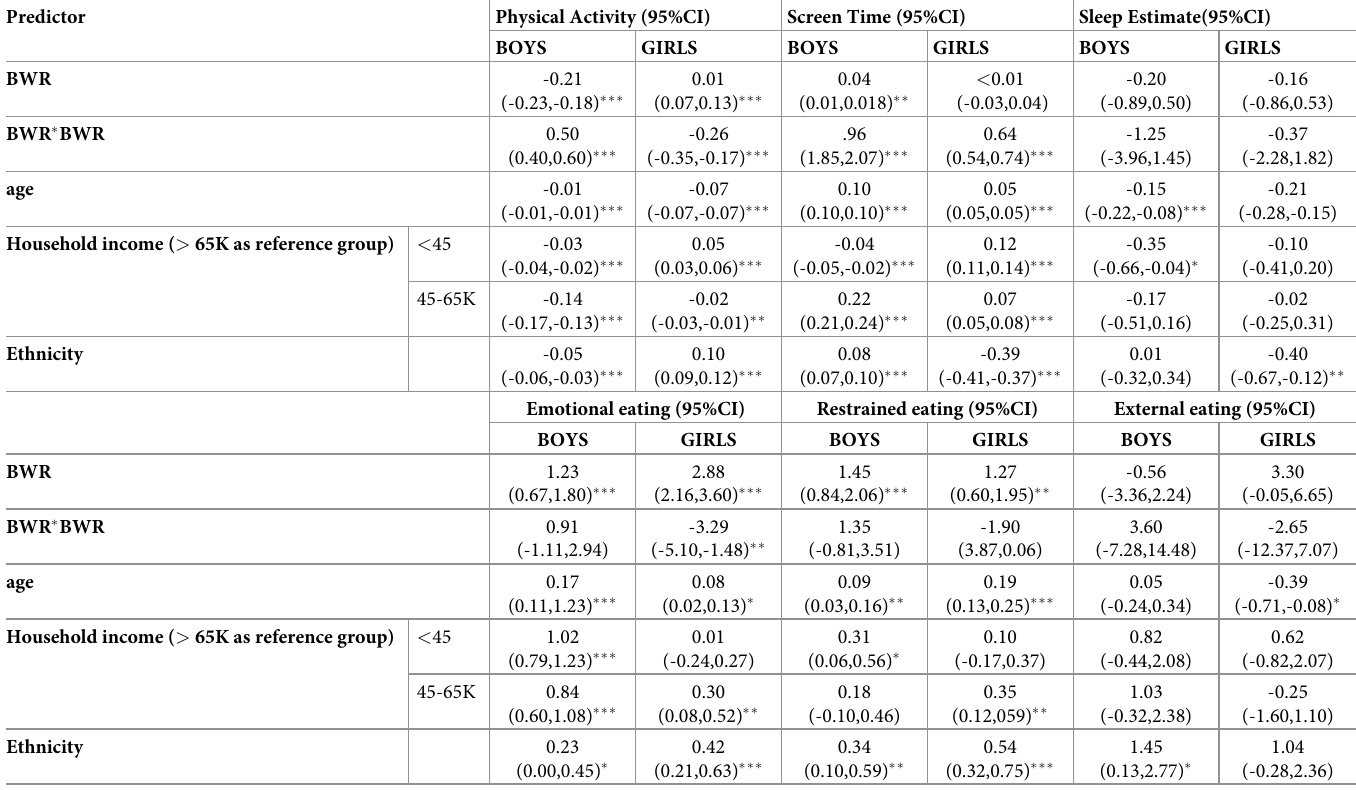
Physical activity, screen time, emotional eating and dietary restraint were modelled using Poisson models. Screen time and external eating were modelled using linear regression � <